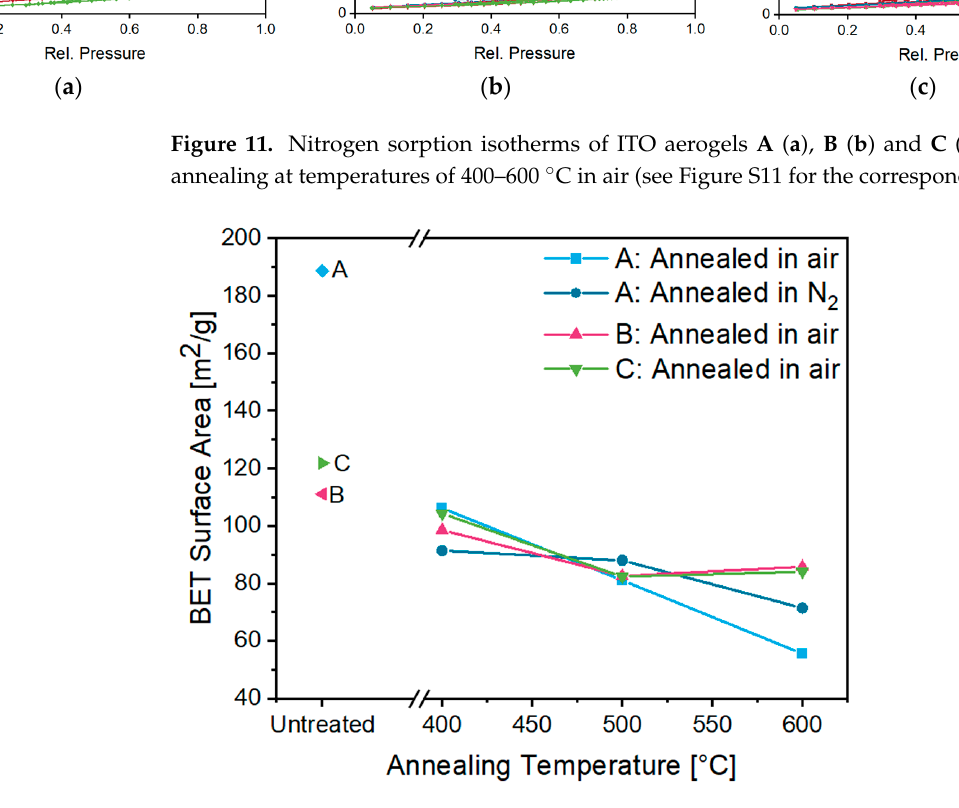
Figure 12. BET surface area of ITO aerogels A (blue diamond), B (rose left triangle) and C (green right triangle), and of the corresponding calcined aerogels after annealing in air or N 2 at temperatures from 400 to 600 °C.